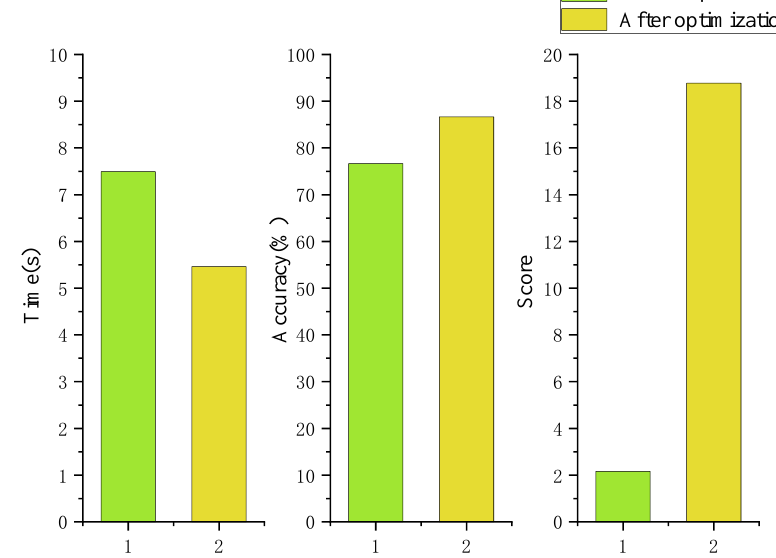
Figure 21. Comparison chart of experimental results.